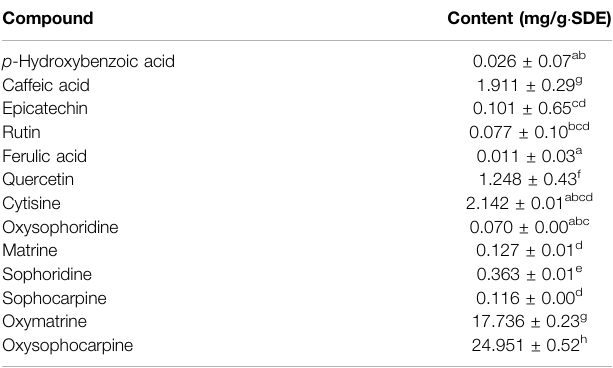
AChE activity increased signi fi cantly in the D – gal group ( p < 0.05; Figure 4 ), indicating the success of modeling. The AChE activity in the midbrain of the SH group and the Vc group decreased